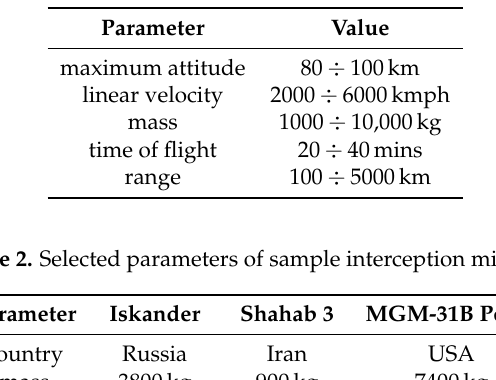
Table 1. Standard parameters of interception missiles.